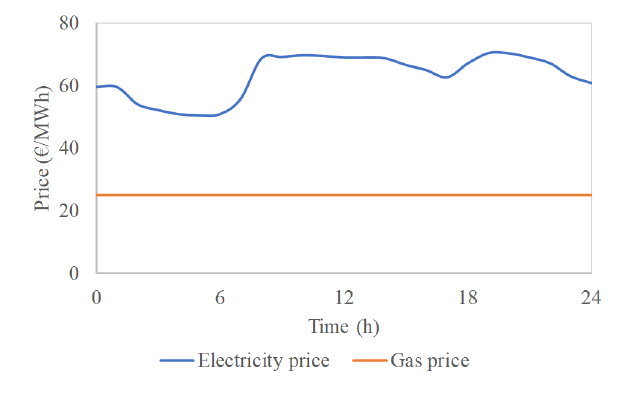
Figure 7. Electricity and gas